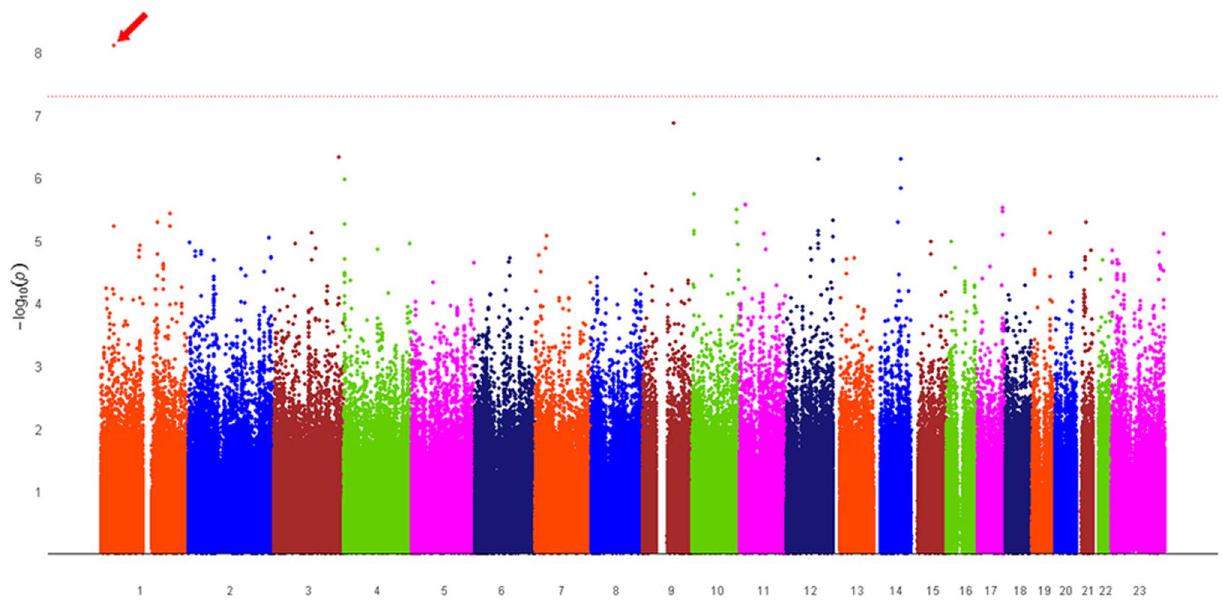
Figure 6. Manhattan plot of –log 10 P from MH test across all 23 chromosomes for Linkage MS EA data. The dashed red line shows the genome-wide significant level –log 10 (5 6 10 2 8 ) < 7.3. SNP rs11583322 has given –log 10 P < 8.1 above this level that lies in gene STK40.